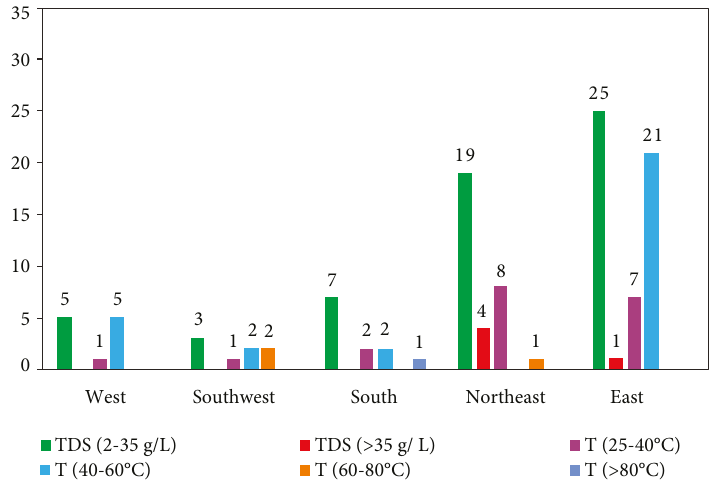
Figure 4: TDS and temperature of some of the springs in the Sichuan